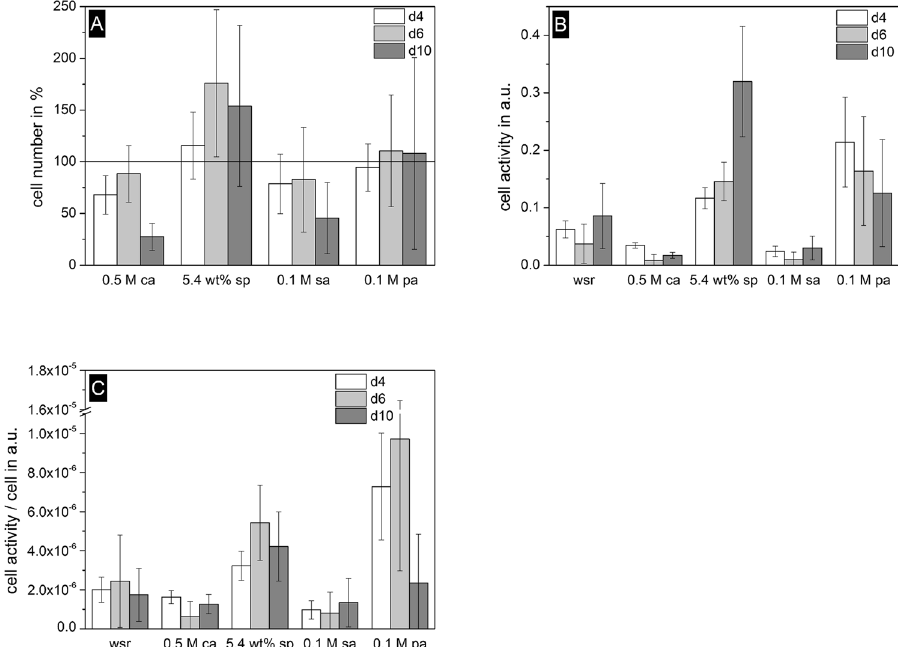
Figure 1. Percent cell number with regard to cement without setting retardant (solid line at 100%) ( A ), cell activity ( B ) and cell activity per cell ( C ) of hFOB. Samples without setting retardant (wsr) and retardants citric acid (0.5 M ca), sodium pyrophosphate (5.4 wt% sp), sulfuric acid (0.1 M sa) and phytic acid (0.1 M pa) were used on day 4, 6 and